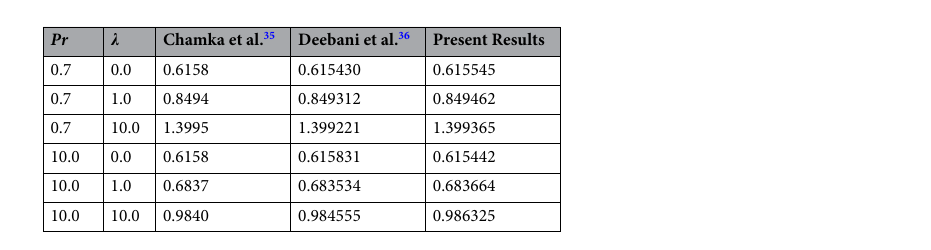
Table 2. The comparative outputs with respect to